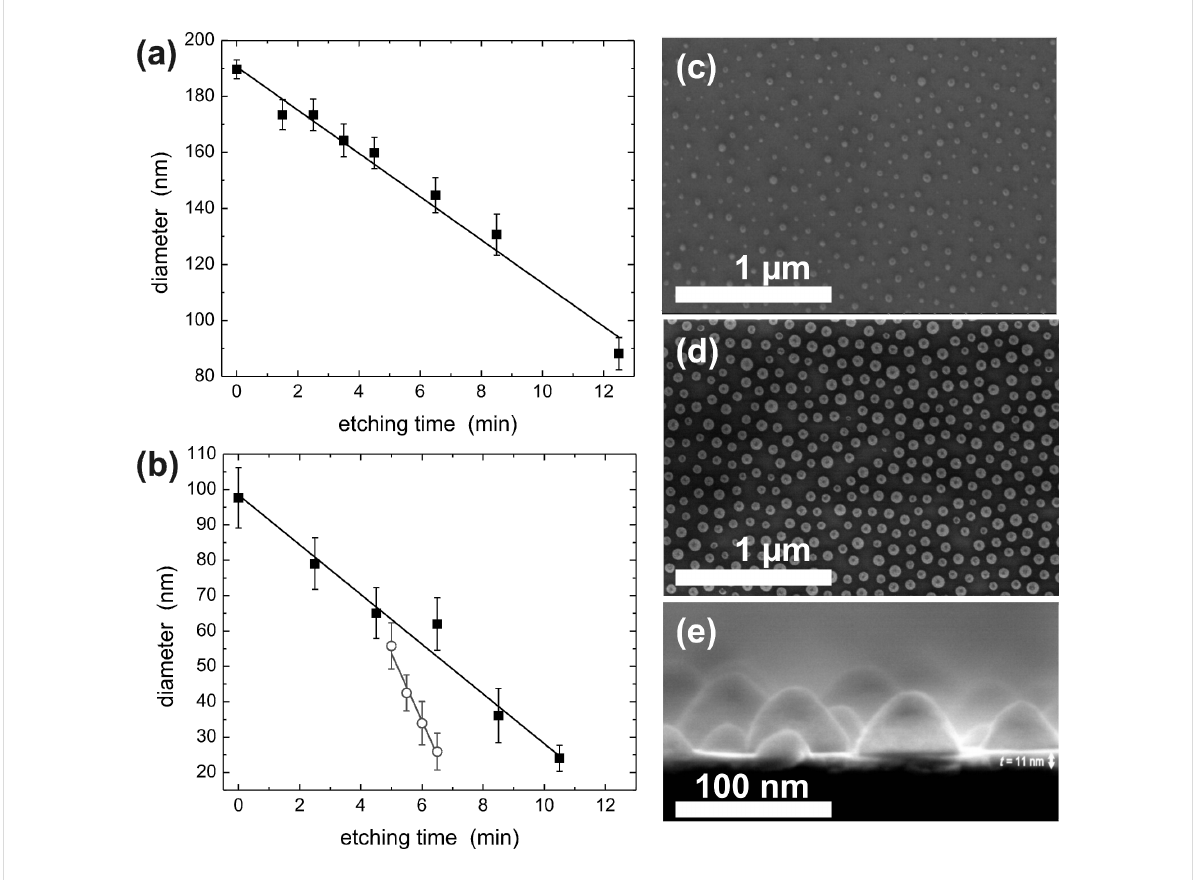
Figure 3: Size reduction of PS spheres as a function of etching time in isotropic oxygen plasma at ambient temperature for an initial particle diameter of (a) 190 ± 3 nm and (b) 95 ± 8 nm. Details are given in the text. Panels (c) and (d) show top-view SEM images of percolated Fe films deposited on size-reduced PS spheres of d = 35 ± 8 nm and d = 50 ± 8 nm at distance a = 95 ± 7 nm, respectively. The cross-section SEM image in (e) clearly reveals the magnetic-cap structure on PS spheres at film thickness t = 11 ± 1 nm on Si/SiO 2 substrates. Panels (a) and (b) are reproduced with permission from reference [19] – Copyright 2009 Wiley.